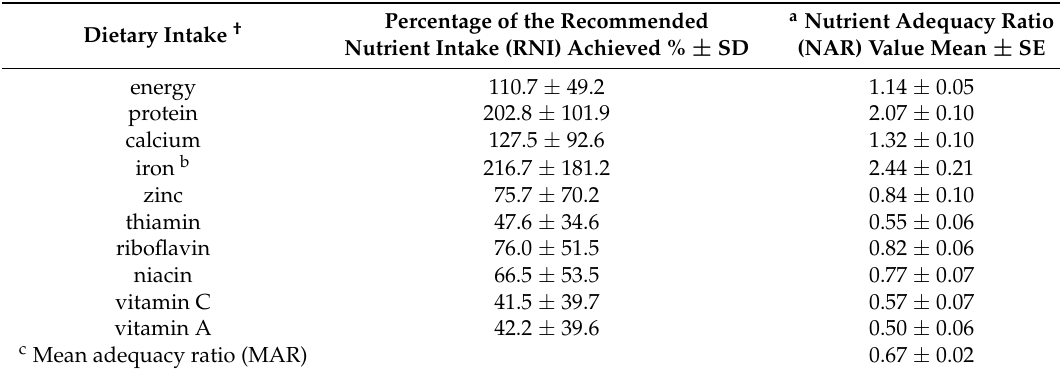
Table 3. Energy and nutrient intake adequacy ( N =